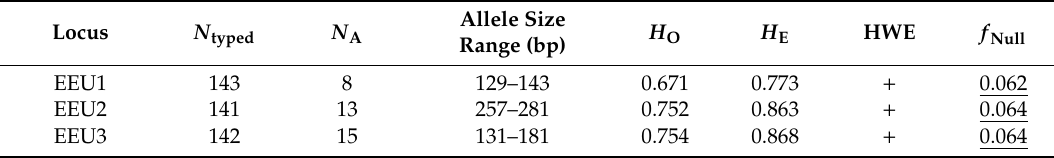
Table 1. Indices of ten microsatellite loci across the 143 unique genotypes (upper part) and averaged for the clusters (lower